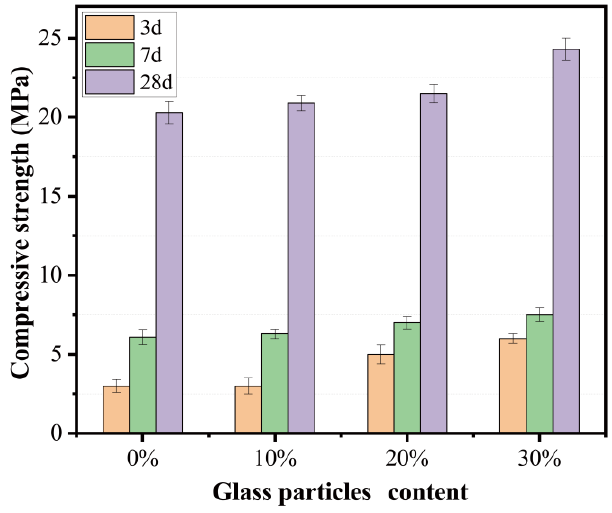
Figure 15. Effect of recycling glass content on mortar strength.